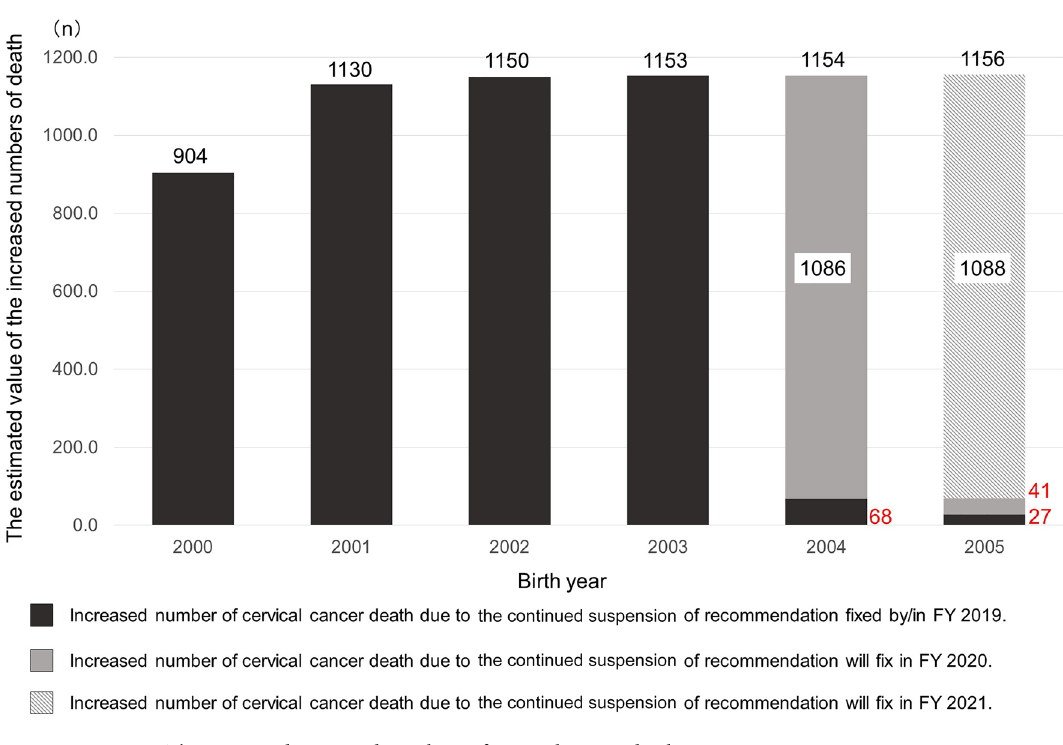
Figure 3. The estimated increased numbers of cervical cancer deaths.